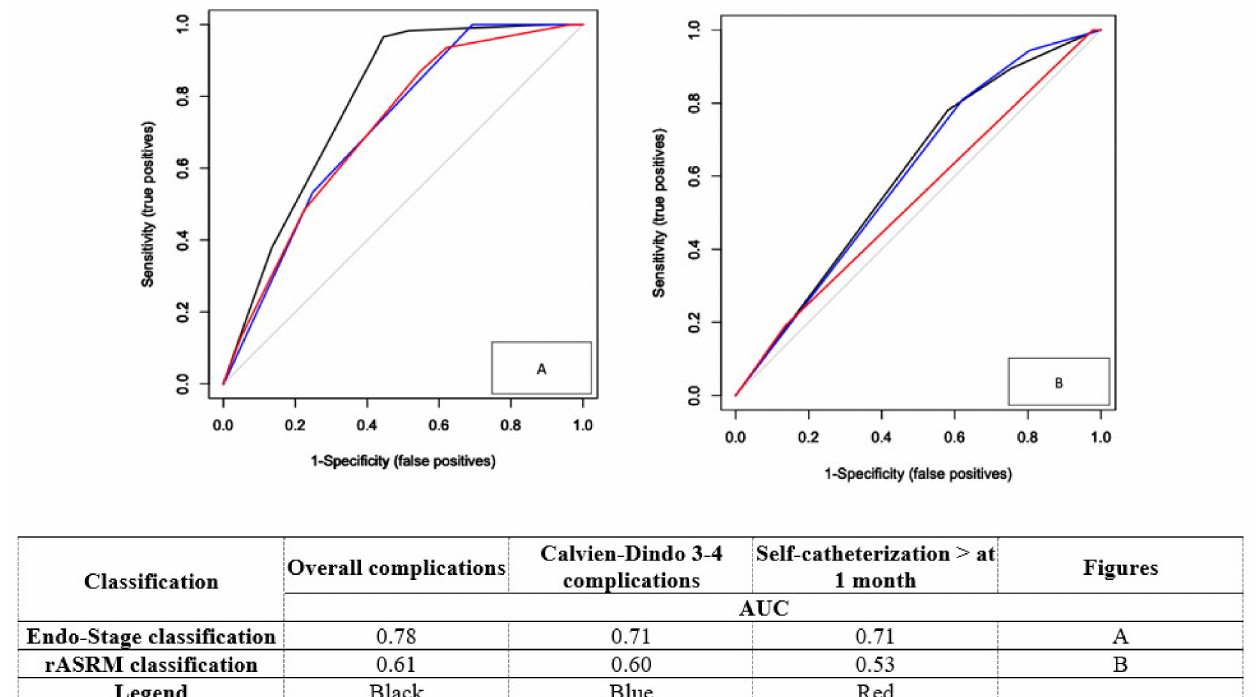
Figure 7. Comparison of Endo-Stage MRI classification and ASRM accuracies to predict surgical outcomes compared to equivalent stages. AUC: Area under the curve, rASRM: The revised American Society for Reproductive